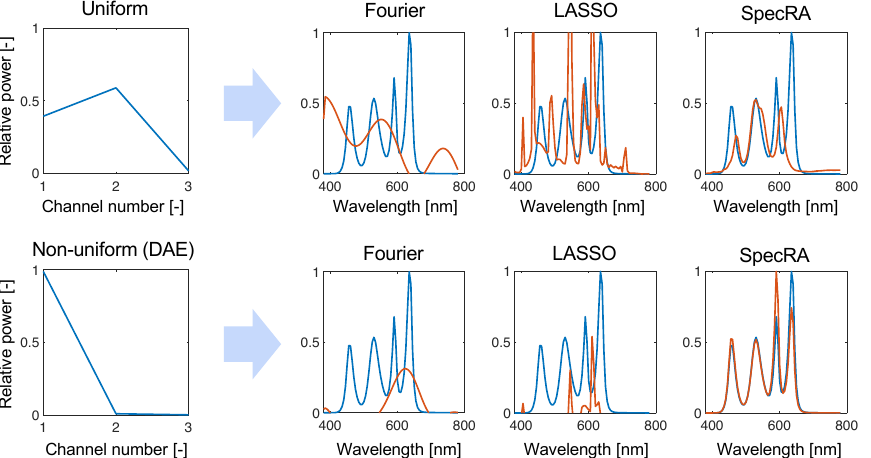
Figure 6. Comparing the performance of the algorithm in the “extreme” undersampled case of p = 3, we see how SpecRA outperforms the other methods, mostly by avoiding overfitting. Furthermore, the performance is improved when the signal is encoded with a learned non-uniform protocol (in this case, derived from the weights learned by training a deep autoencoder